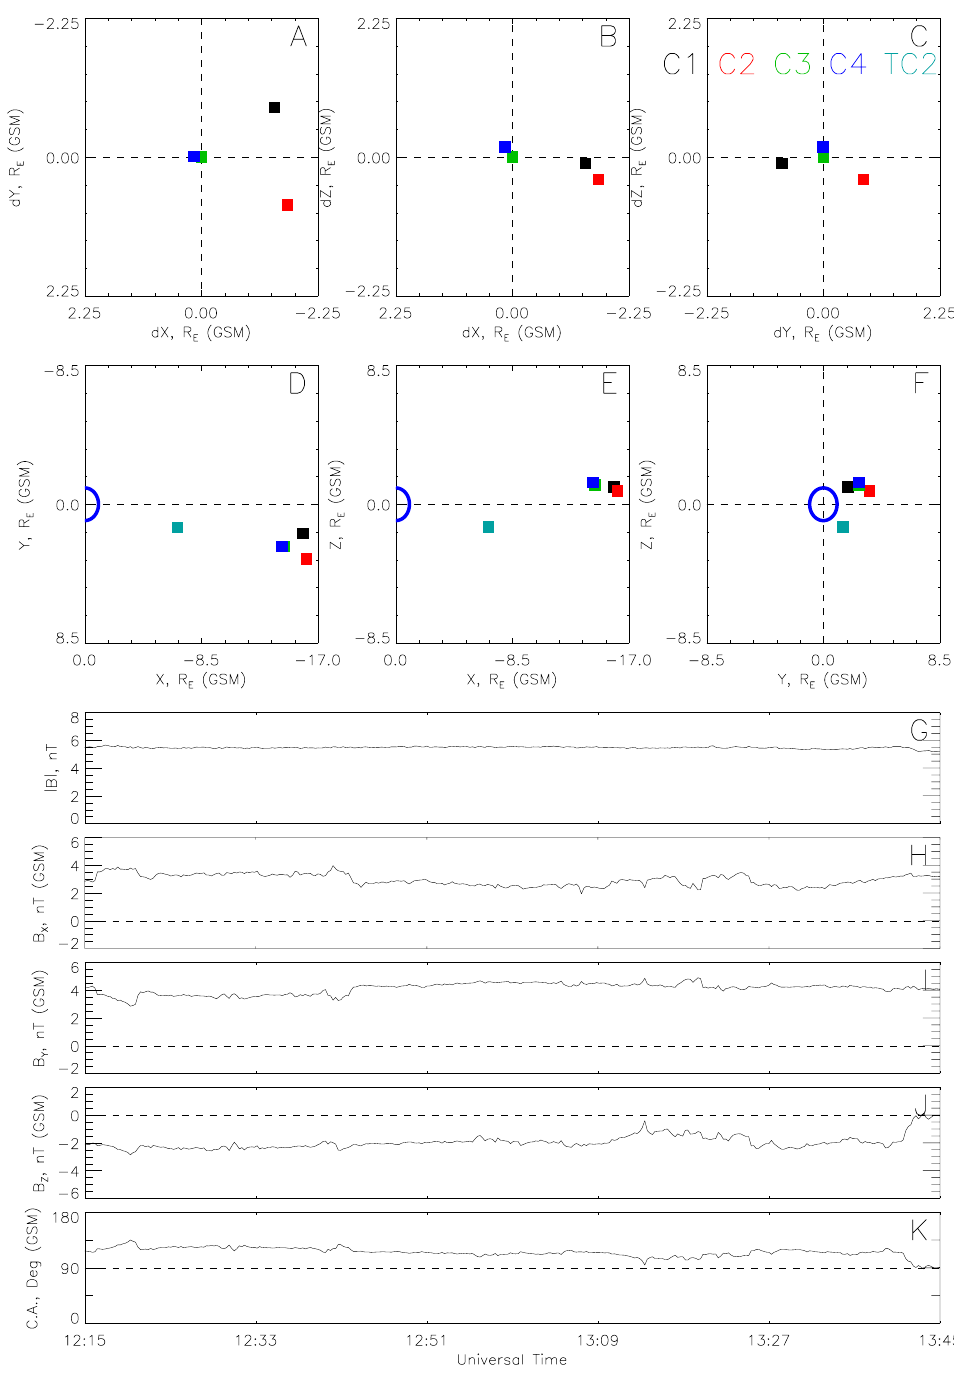
Fig. 1. The configuration of the Cluster tetrahedron (panels A–C ) and the postions of Cluster and Double Star TC-2 (panels D–F ) at 14:00UT on 21 September 2005 in the GSM coordinate system. The Cluster spacecraft are in a so-called “multiscale” configuration, where C1 (black), C2 (red) and C3 (green) form a triangle of side ∼ 10000km with C4 (blue) displaced in ∼ Z by ∼ 1000km. Panels (G–J) are the magnitude and GSM components of the Interplanetary Magnetic Field, and panel (K) the IMF clock angle as measured by the MFI instrument on board the ACE spacecraft. These data have not been lagged to the